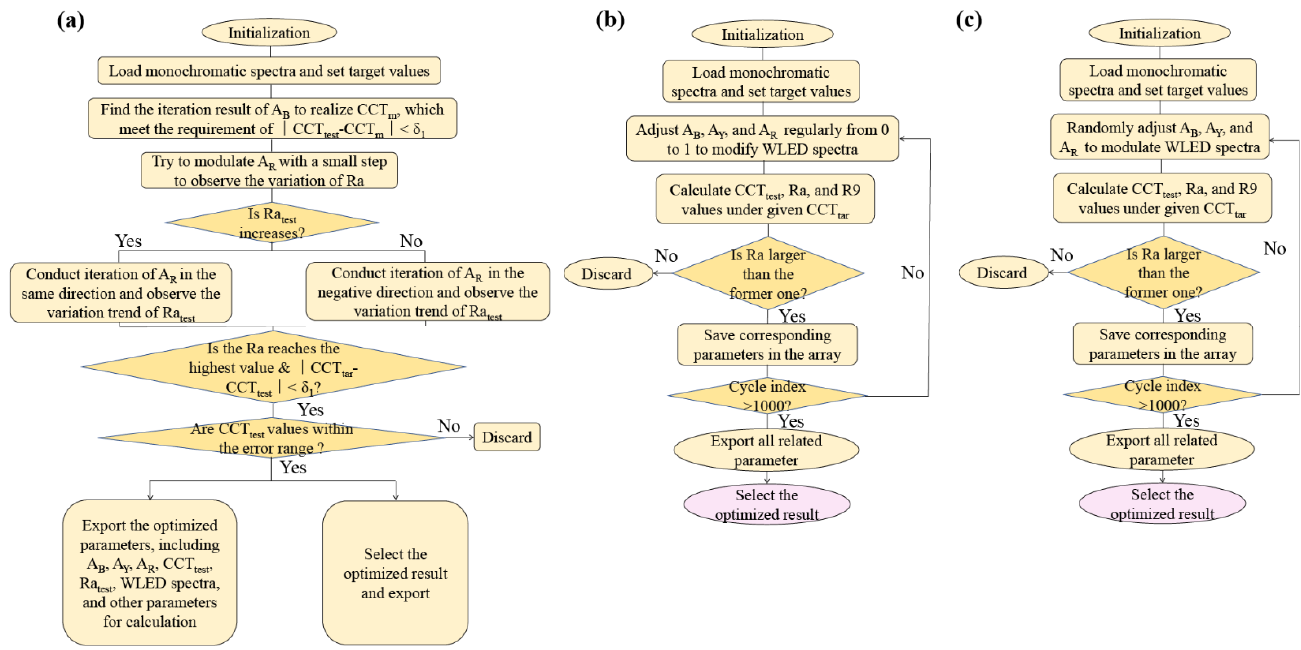
Figure 2. Flow diagrams of ( a ) the proposed method, ( b ) method I, and ( c ) method II, in which methods I and II are conventionally used for spectral optimization.